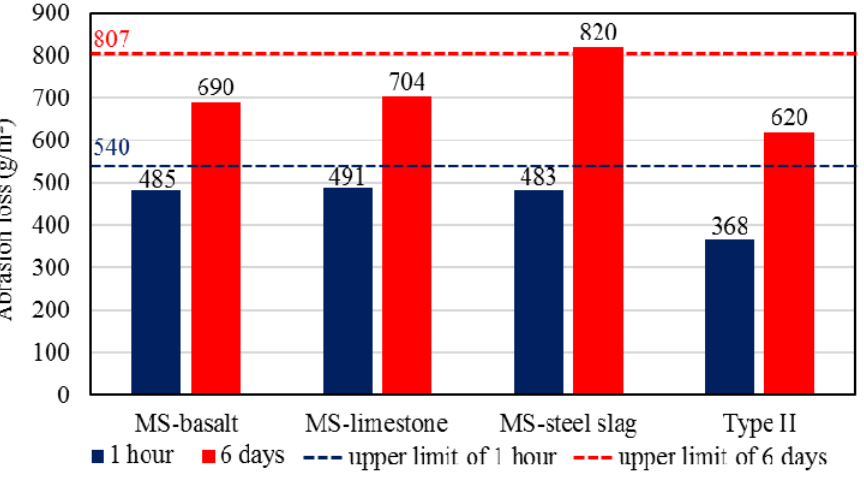
Figure 10. Abrasion loss of different kinds of samples.